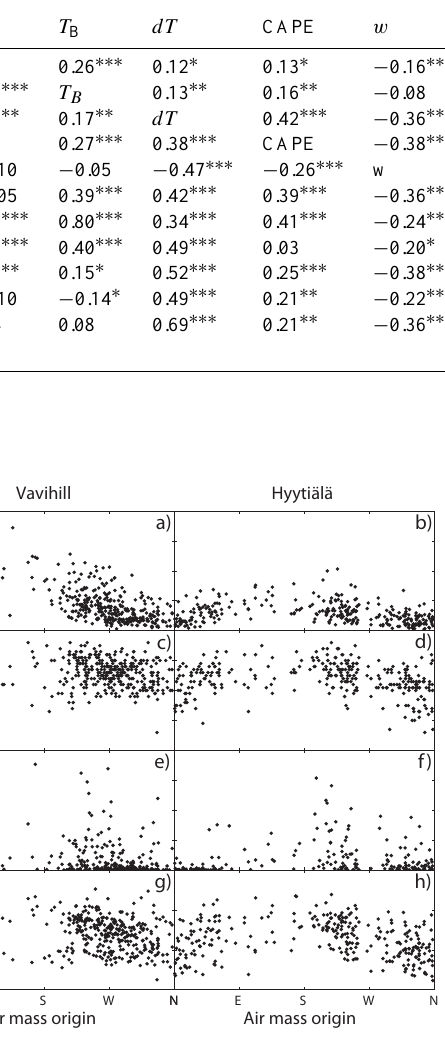
Fig. 2. The figure shows how the following parameters vary with air mass origin: N 80 (row 1), T B (row 2), CAPE (row 3) and SH (row 4). The data from Vavihill is presented in column 1 and the data from Hyytiälä in column 2. N 80 is the number concentration of particles with a diameter above 80nm, T B is the cloud base tem- perature, CAPE is the convective available potential energy and SH is the specific humidity at 1000hPa. Only data from the 388 and 295 selected cloud scenes for Vavihill and Hyytiälä respectively, are shown.